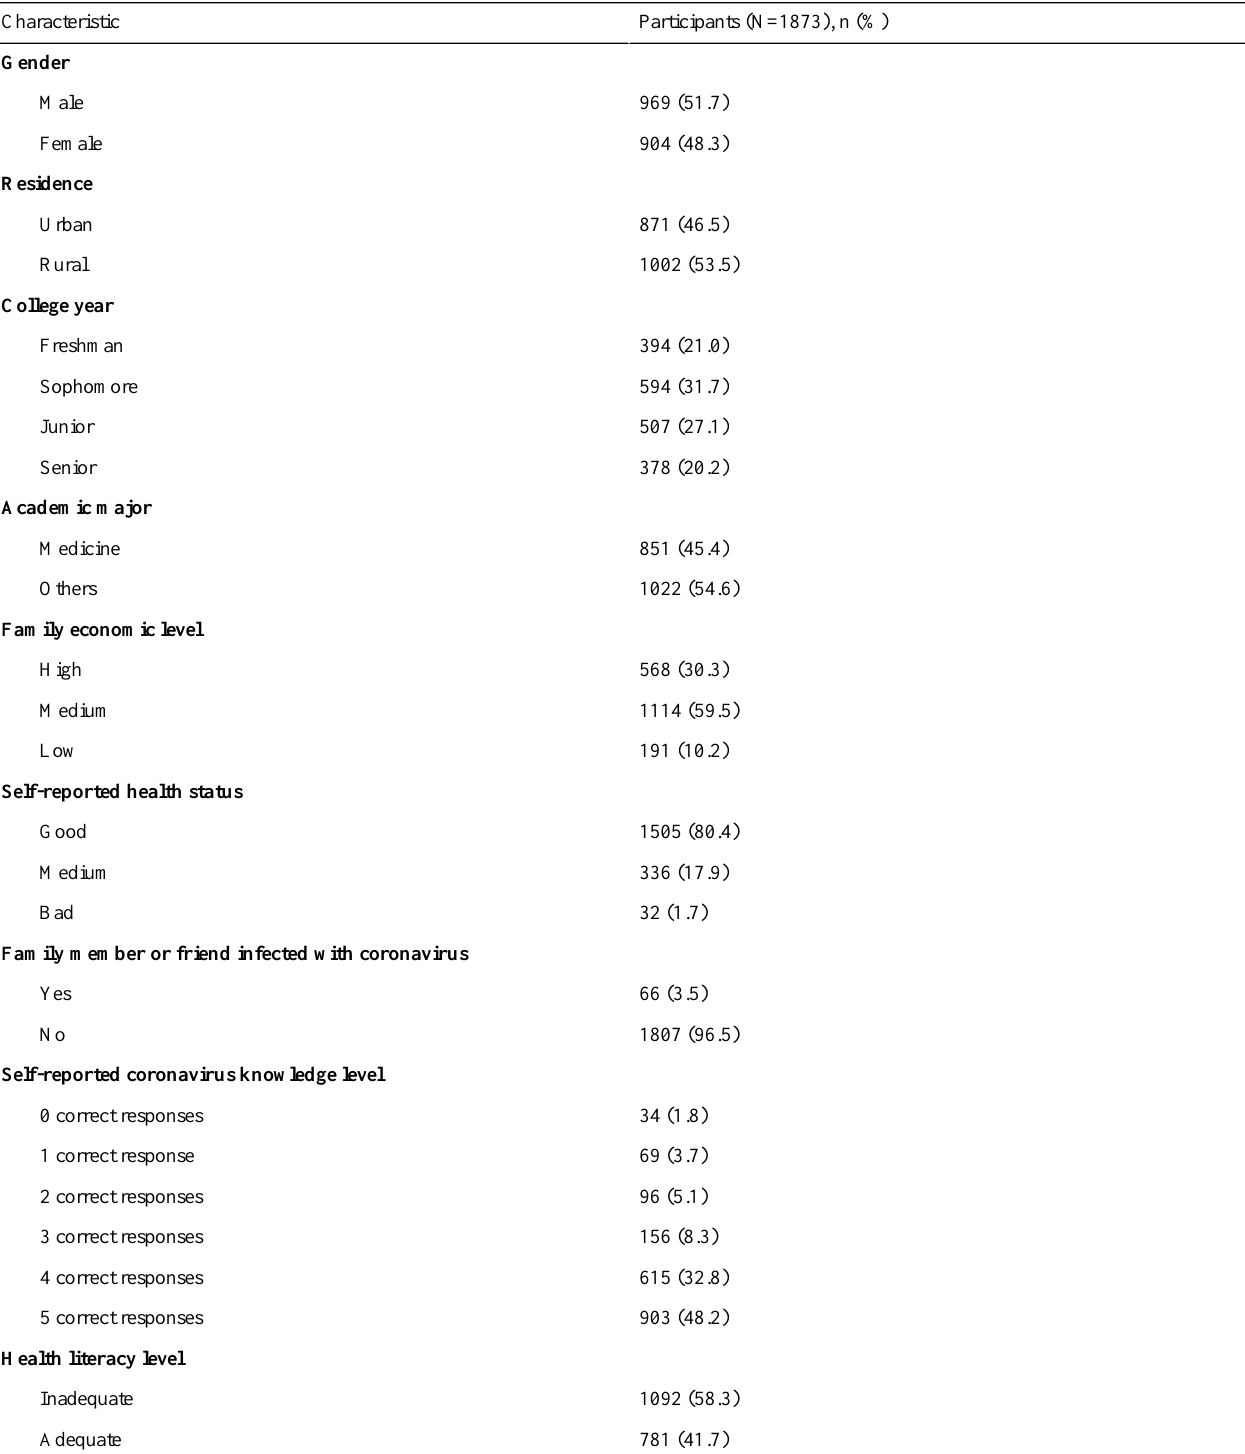
Table 1. Descriptive statistics of sociodemographic characteristics of the study